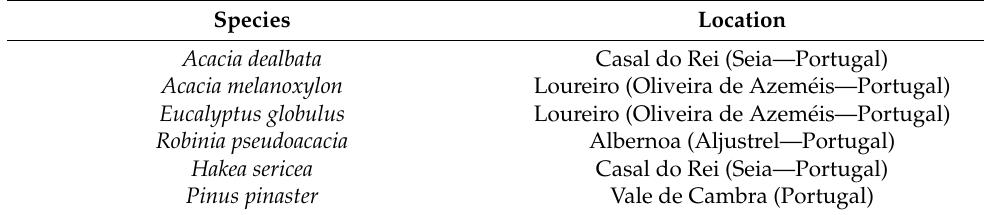
Table 3. Location of sample collection points used in the present study.